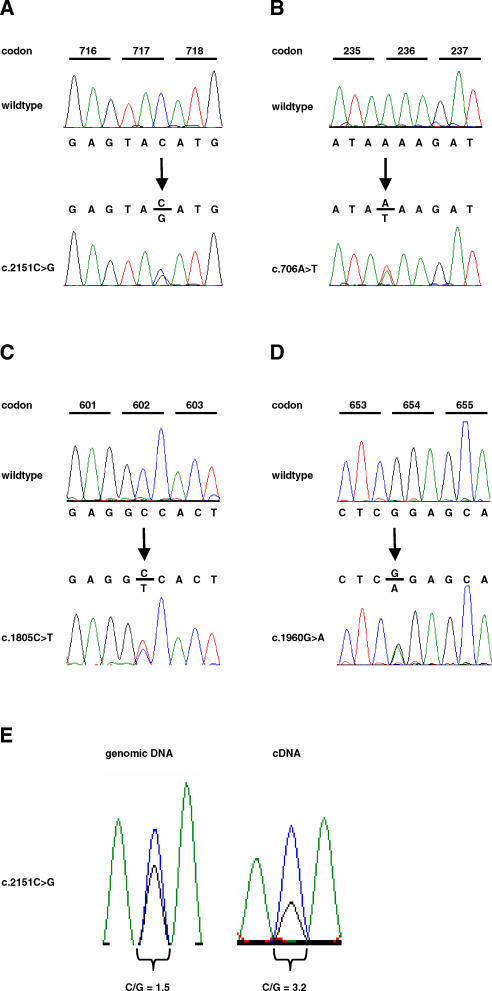
Mutations in the Equine KIT GeneDirect sequencing of genomic PCR products from solid-colored and dominant white horses revealed four nonsynonymous polymorphisms that were exclusively found in white horses. (A) Exon 15, c.2151C>G mutation in a white Franches-Montagnes Horse.(B) Exon 4, c.706A>T mutation in a white Arabian.(C) Exon 12, c.1805C>T mutation in a Camarillo White Horse.(D) Exon 13, c.1960G>A mutation in a White Thoroughbred.(E) Electropherograms of exon 15 sequences from a dominant white Franches-Montagnes Horse derived from genomic DNA and cDNA. The presence of the polymorphism is clearly visible on the genomic DNA and on the transcript level. The reduced signal intensity of the mutant G allele in the cDNA sequence indicates a reduction of the mutant transcripts compared to the wild-type transcripts of about 50%.